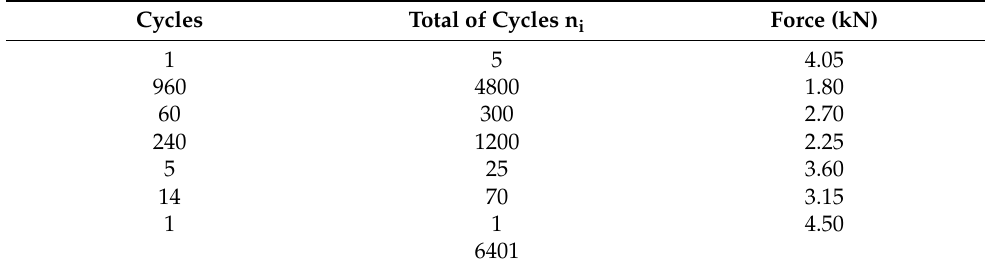
Table 8. Total number of